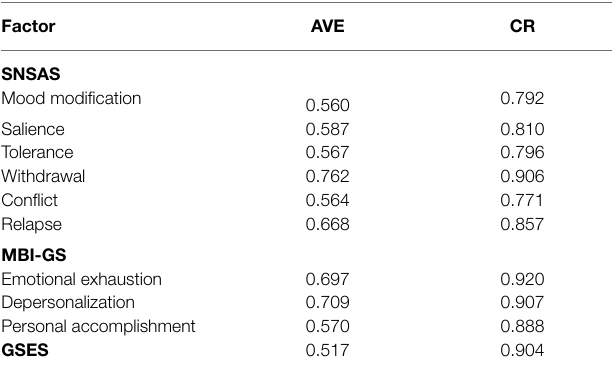
TABLE 1 | CFA test results of Social Networking Service Addiction Scale (SNSAS), Maslach’s Burnout Inventory-General Survey (MBI-GS), and General Self-efficacy Scale